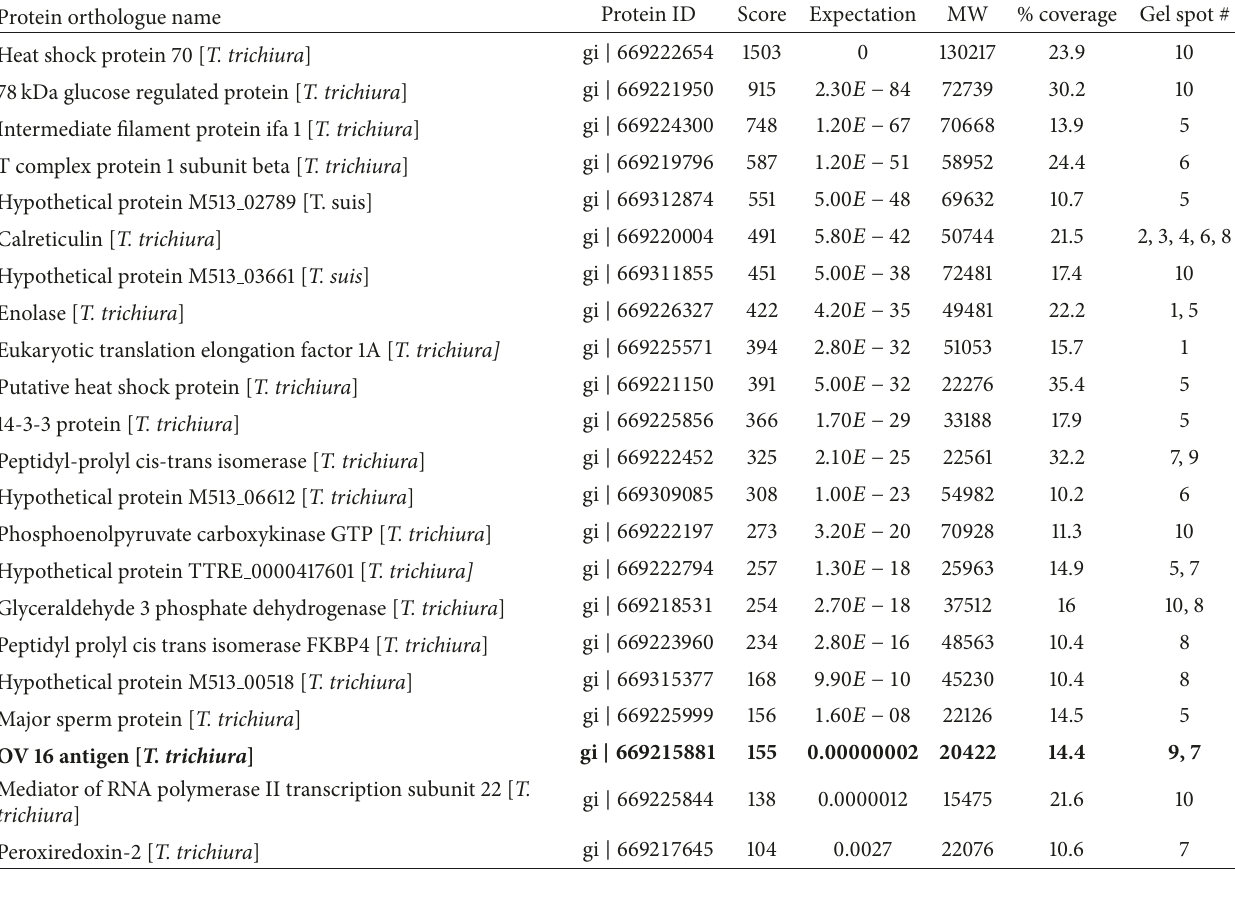
Table 2: Proteins identified by mass spectrometry (Tm16 is written in bold).